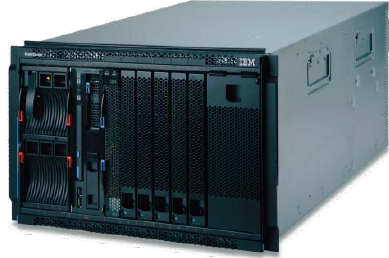
Figure 5. Computer cluster